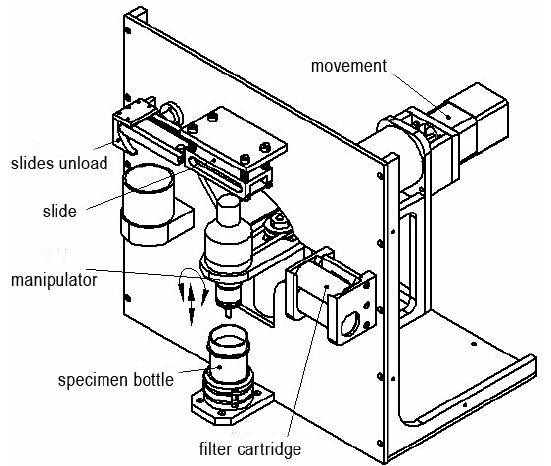
Figure 3. Schematic diagram of the production machine.